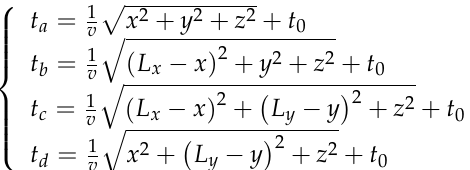
Figure 10. The spectrum of the phase difference of the simulated signal arriving at two sensors.